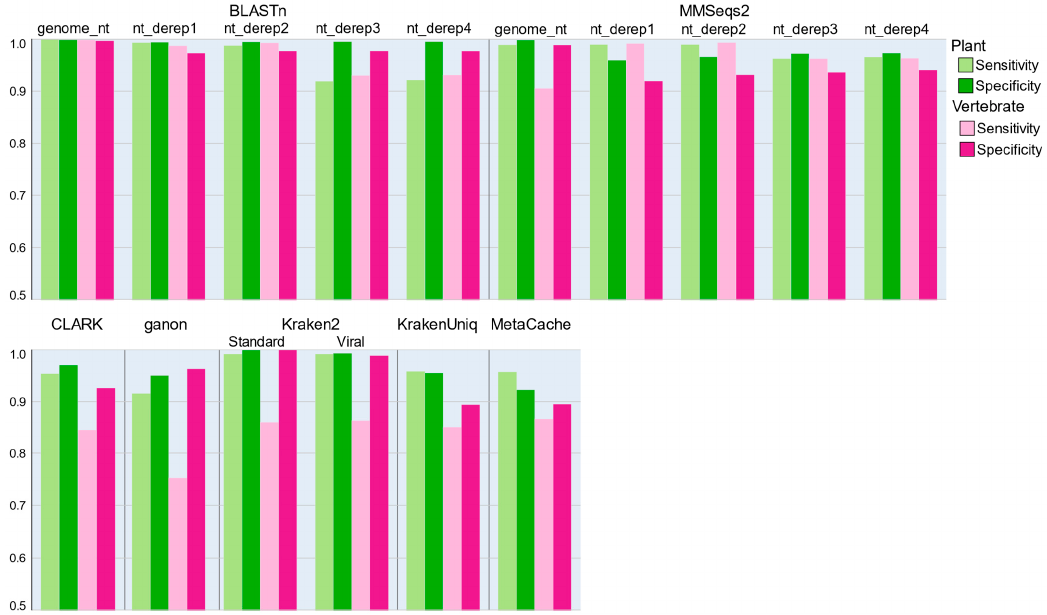
Figure 2. Sensitivity for detection of plant- and vertebrate-infecting viruses, and specificity against plant and vertebrate sequences, using nucleotide classification methods. (Top) BLASTn and MMSeqs2 classifications against each of the in-house nucleotide databases, after filtering for results with at least 70% identity over 50% of the query length and an e-value of less than 0.001. (Bottom) Classification using k-mer profiling tools after result filtering with the appropriate classification threshold for each tool. Classification was performed against a single database, except for Kraken2, in which case both the standard and viral databases were tested.